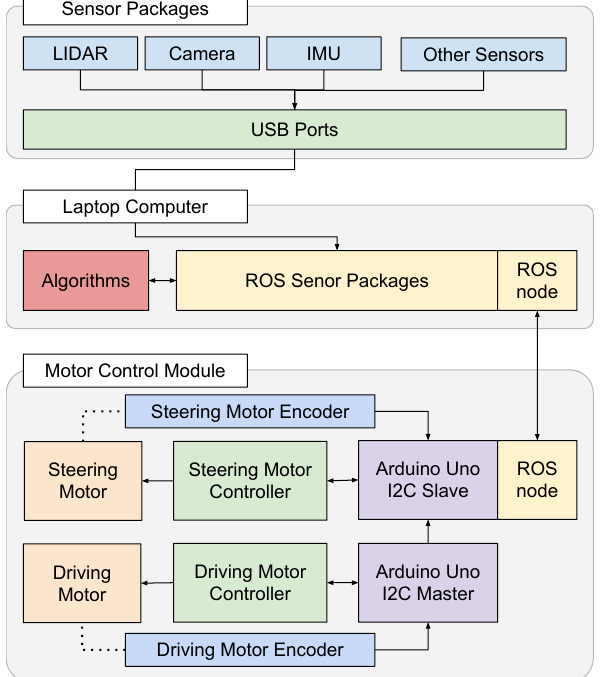
Figure 3. The block diagram of the Ridon Vehicle platform. The laptop computer hosts device drivers of the sensor packages and runs a ROS node that communicates with the microcontrollers through the ROS serial communication. The motor control module’s only concern is the low-level motor control and it is independent of the main unit where higher-level perception and control algorithms are executed. The components in one module are easily replaceable without affecting other